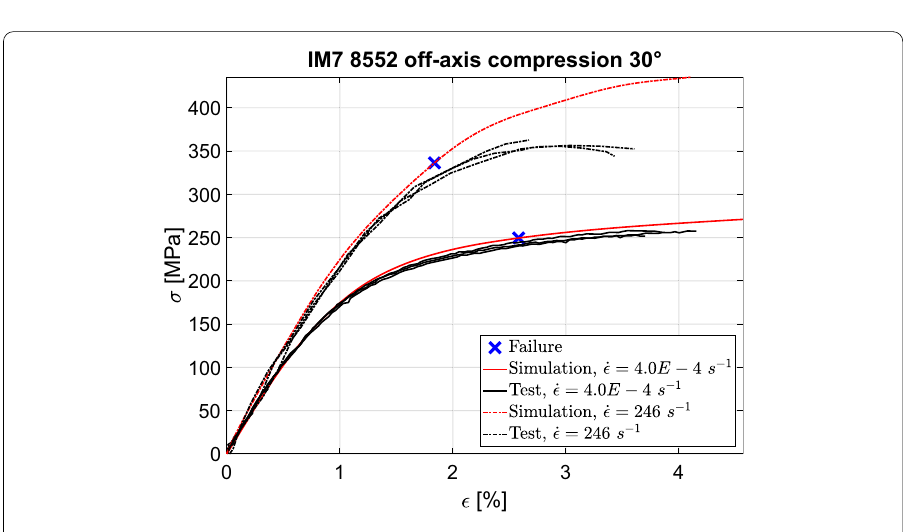
Fig. 17 True stress–true strain curves for the compression tests and simulations, 30